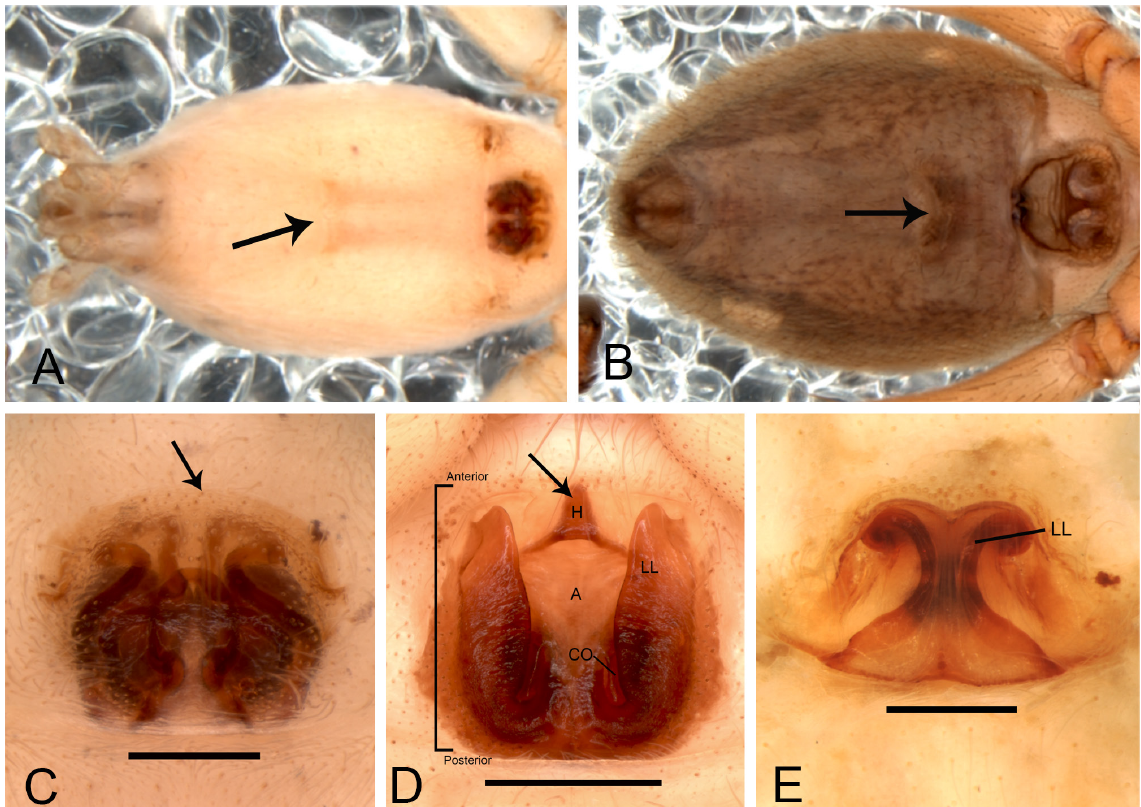
Fig. 7. A . Arachosia praesignis (Keyserling, 1891), ♀, abdomen, ventral view (arrow indicating position of tracheal spiracle) (IBSP 87975). B . Aysha prospera Keyserling, 1891, ♀, abdomen, ventral view (arrow indicating position of tracheal spiracle) (IBSP 19783). C . Arachosia praesignis , epigynal plate, dorsal view (arrow indicates the absence of a hood) (IBSP 87975). D . Patrera fulvastra Simon, 1903, epigynal plate, dorsal view, (arrow indicates the hood) (MCN 24208). E . Xiruana gracilipes (Keyserling, 1891), epigynal plate, dorsal view (IBSP 166120). Abbreviations: A = atrium; CO = copulatory opening; H = hood; LL = lateral lobes. Scale bars: D = 0.6 mm; C, E = 0.25